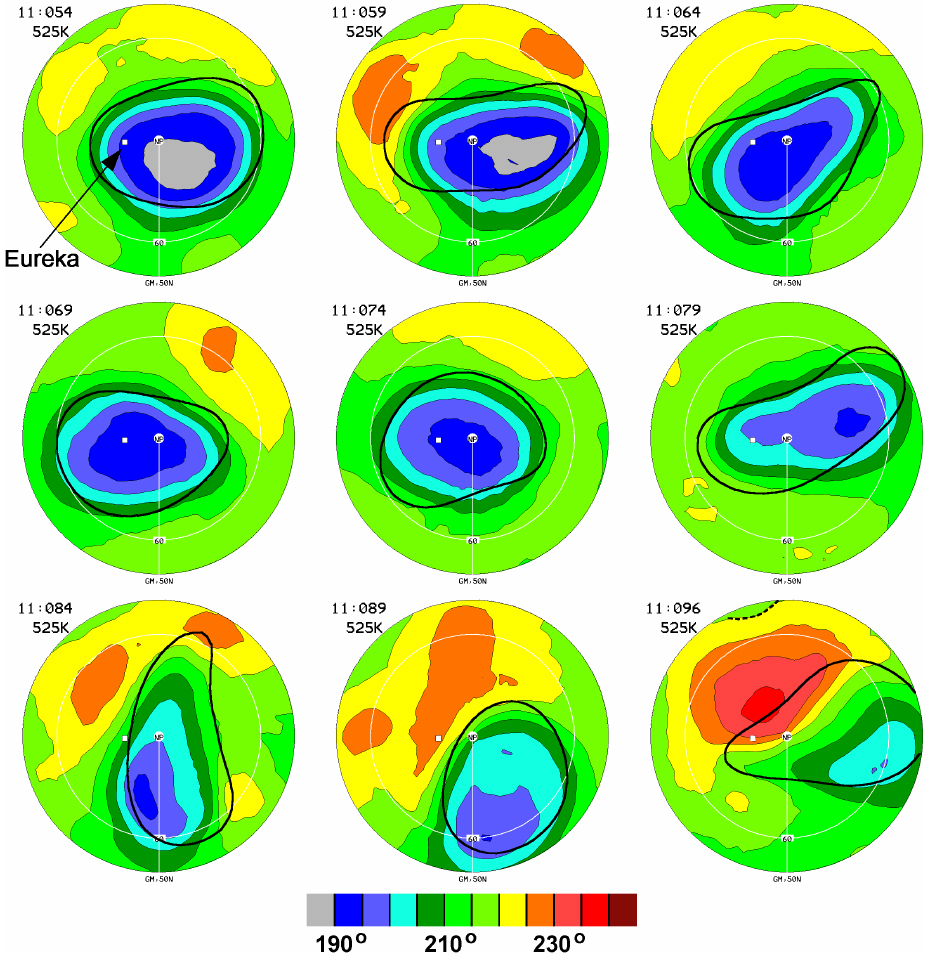
Fig. 2. MetO 5-K temperature contours for the 525-K potential temperature level (color-coded as shown in the legend), with the overlaid vortex edge for the same level (black solid line). These contours correspond to the days shown on the top left side of each map. The white square indicates the location of Eureka, while the white circle indicates 60 ◦ N latitude. The southern boundary is at 50 ◦ N.